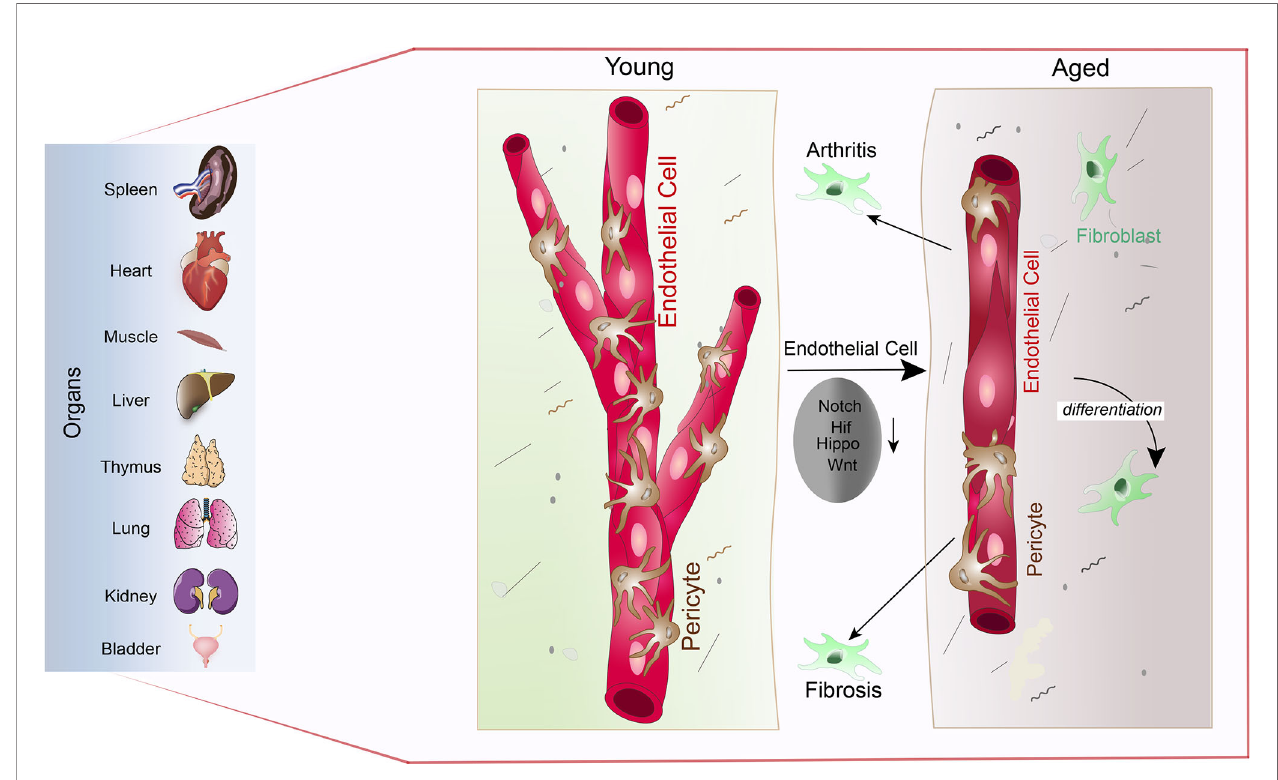
FIGURE 5 | Vascular attrition is a primary hallmark of ageing: Pericytes abundantly cover the endothelial lining throughout the spleen, heart, muscle, liver, thymus, lung, kidney, and bladder (left) in young mice (young). Upon ageing, reduced Notch, Hif, Hippo and Wnt signalling in endothelial cells leads to pericyte loss via pericyte to fi broblast differentiation (aged). Loss of pericytes and accumulation of fi broblasts subsequently supports arthritic and fi brotic